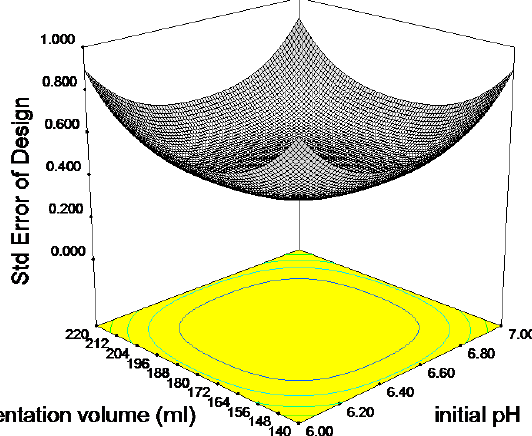
Figure 3. Three-dimensional standard error plot of the model holding initial pH and fermentation volume.